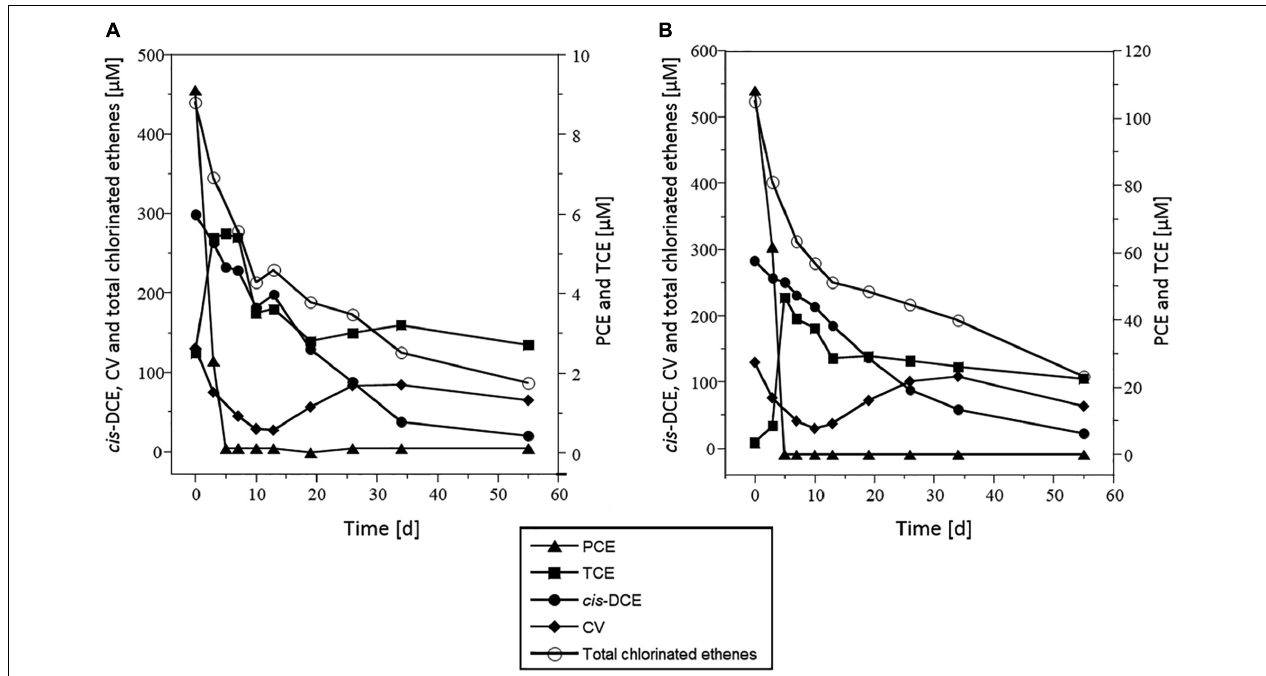
FIGURE 2 | Dissipation of CEs in microcosms spiked with PCE and acetate. Concentrations of PCE (triangles), TCE (squares), cis -DCE (circles), VC (diamonds), and total chlorinated ethenes (white circles), in microcosms spiked with 10 µ M PCE (A) or 100 µ M PCE (B) . Represented values are the average of three replicates. Error bars are not shown for clarity and were below 100% (see Supplementary Figure S1 ). Data from microcosms that received acetate but no Na 2 S are shown as a representative example. Results were very similar for other experimental conditions tested.